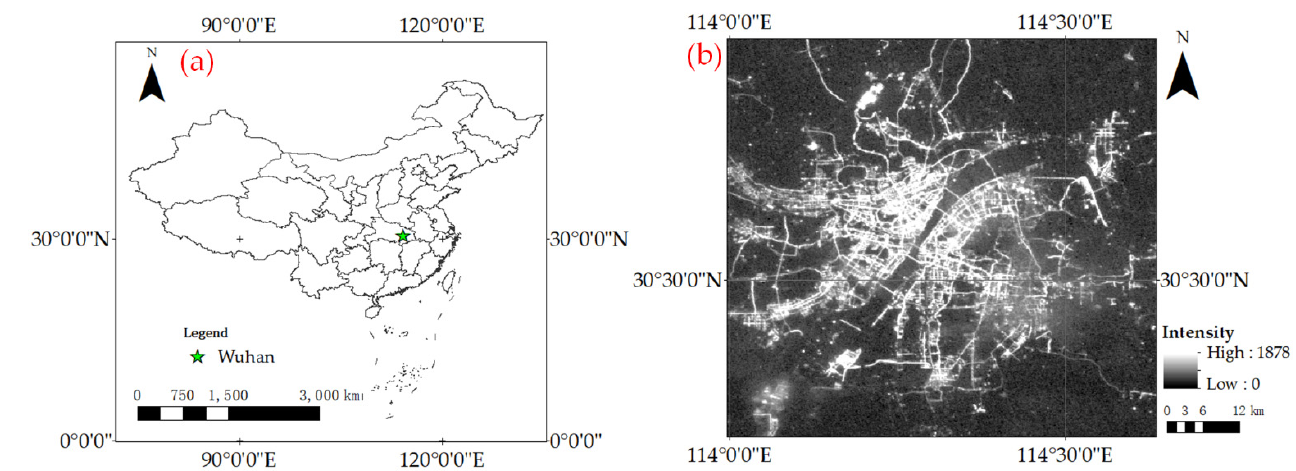
Figure 1. Location of Wuhan ( a ) and its nighttime light data after preprocessing ( b